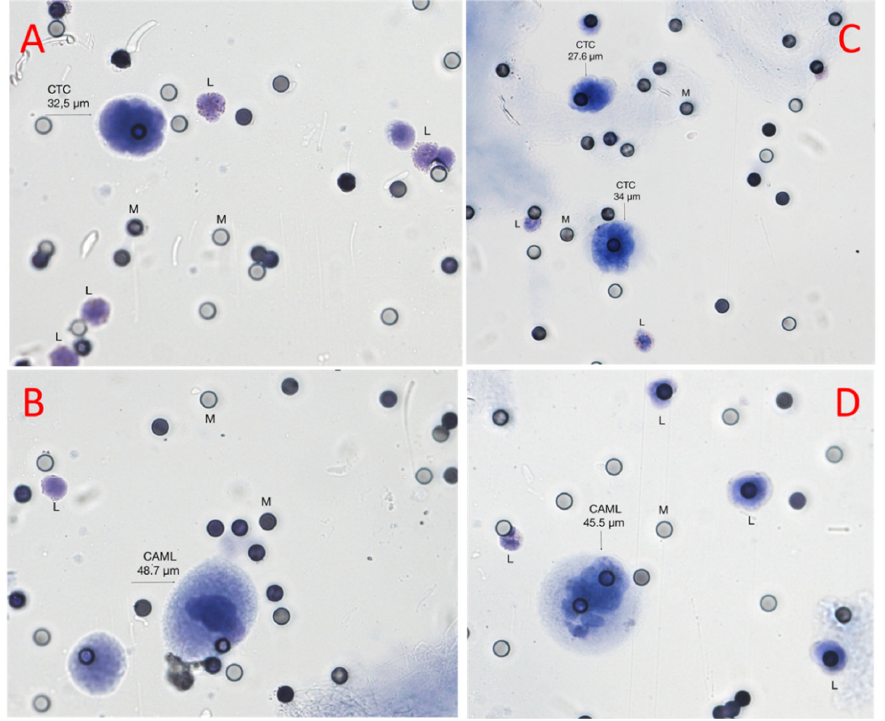
Figure 1. Morphology of the cells identified as CTCs, CAMLs, and normal leucocytes (L) visualized on Screencell © filter colored by May Grunwald–Giemsa, with micropores (M) measuring 6.5 µm in diameter. ( A ) and ( B ) are from patient 9: ( A ) CTC (size = 32.5 microns) characterized by a hyperchromatic nucleus and a high nucleus–cytoplasmic ratio; and ( B ) a typical CAML (size = 48.7 microns) characterized by a low nucleus–cytoplasmic ratio and a normal leucocyte (L) (size = 11.7 microns). C and D are from patient 1: ( C ) 2 CTCs (size = 27.6 microns and 34 microns, respectively) with a large and hyperchromatic nucleus and a high nucleus–cytoplasmic ratio; and ( D ) representative CAMLs characterized by a large and elongated cytoplasm (size = 45.5 microns) and a low nucleus–cytoplasmic ratio.